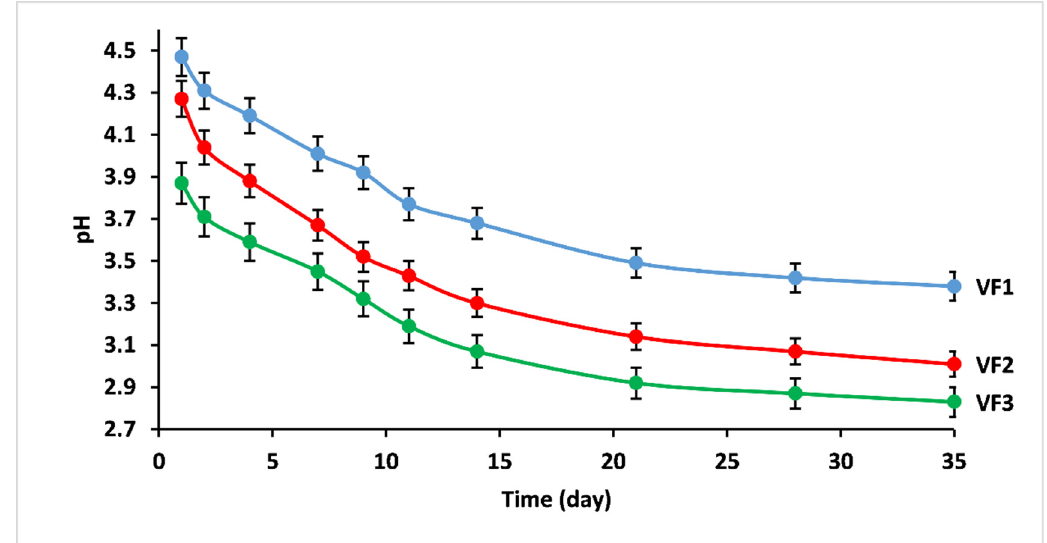
Figure 7. pH variations of the leachate solutions versus dissolution time for concentrations of [K 2 O/(CaO+MgO)] ratio